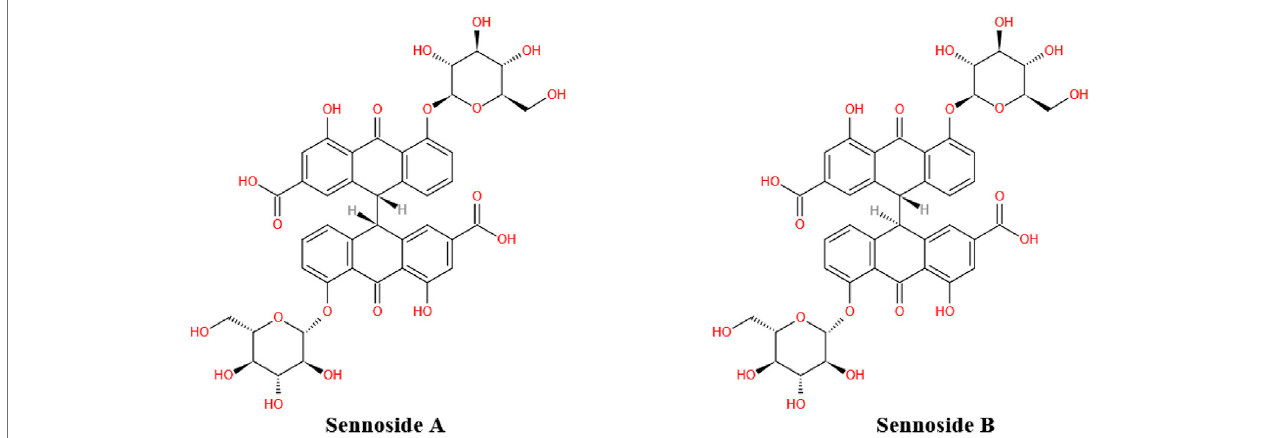
FIGURE 1 | Chemical structure of sennoside A and B. Sennoside A (SA) and its stereoisomer sennoside B (SB) are natural anthraquinone derivative and dimeric glycosides.